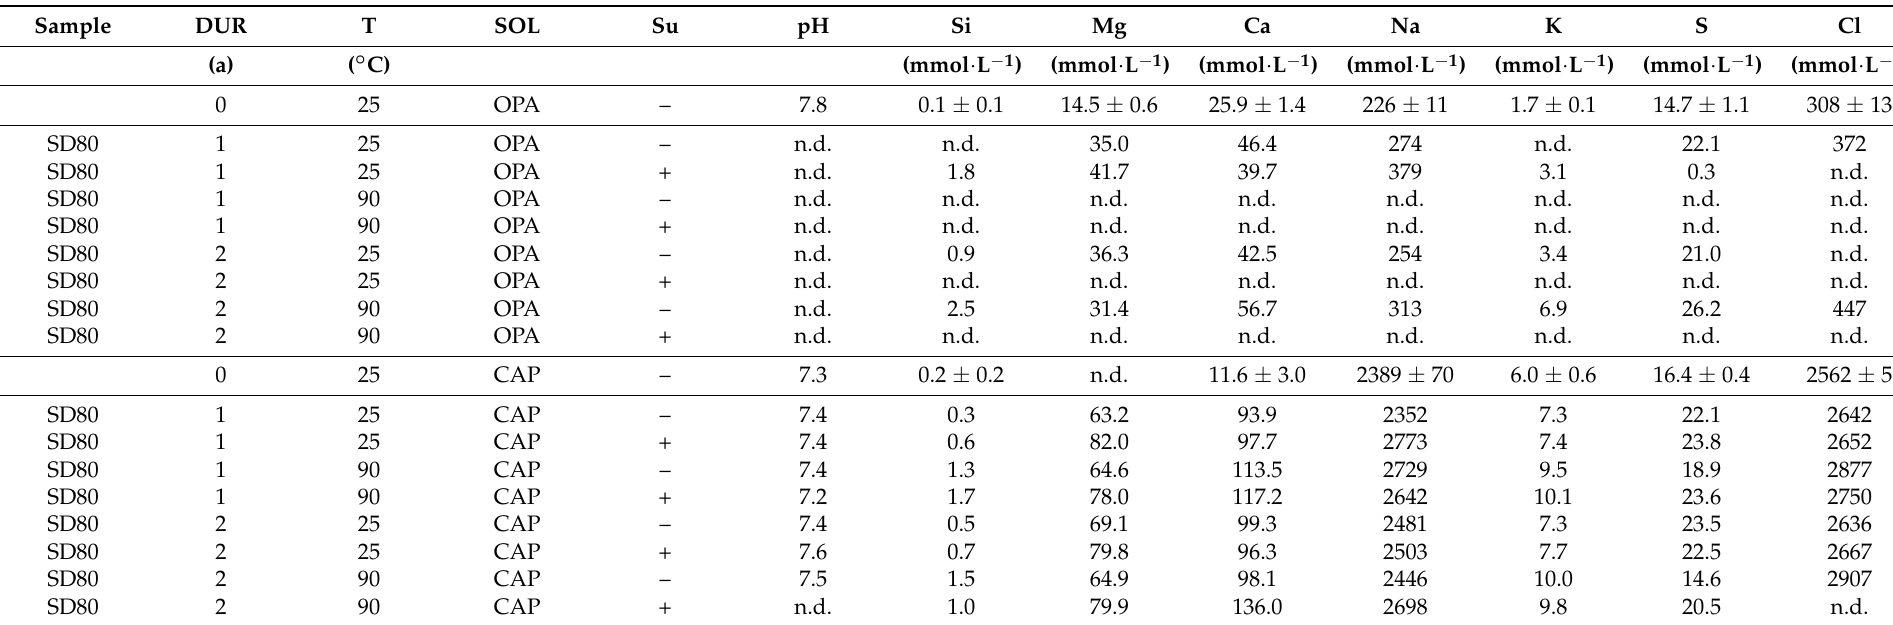
Table 7. Solution chemistry of SD80 bentonite batches and measured pH values (n.d. = not determined due to the complete adsorption of the solution by smectite). DUR: duration, SOL: solution, Su: